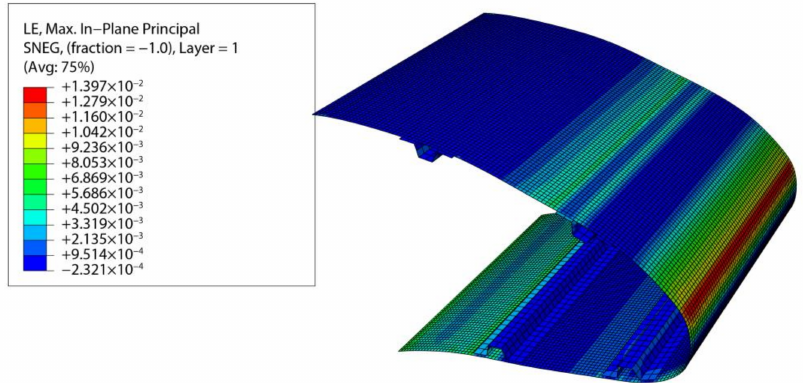
Figure 22. Strain contour of the compliant skin in drooped case.